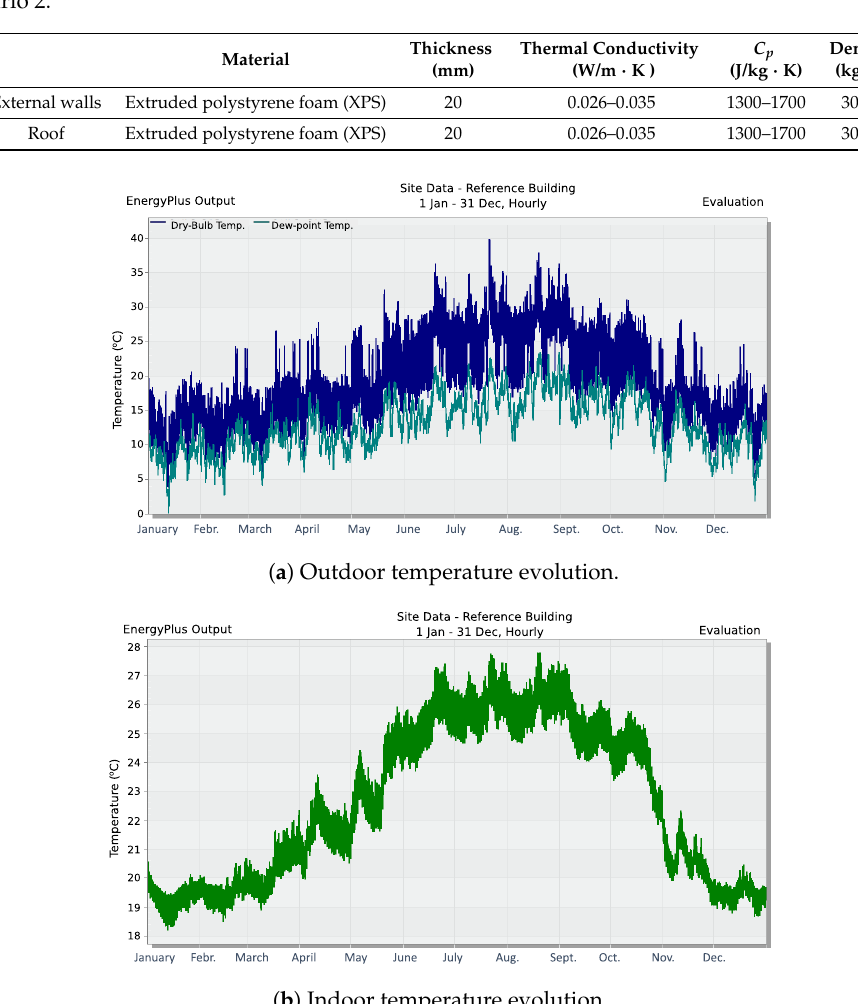
Table 7. Moroccan Thermal Construction Regulation (RTCM) norms: additional thermal insulation— Scenario 2.